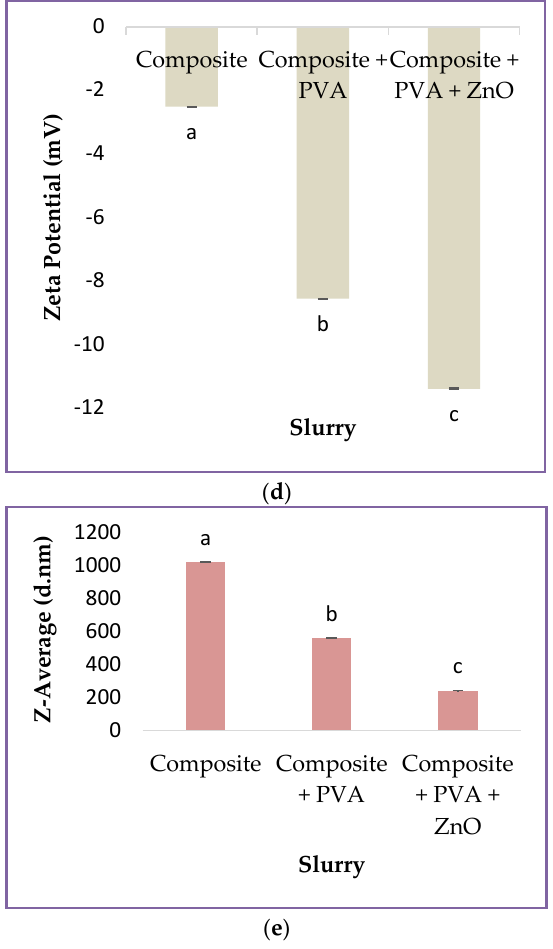
Figure 2. ( a – e ). Properties of different types of slurries used for film formation: ( a ) viscosity, ( b ) pH, ( c ) PDI, ( d ) zeta potential, and ( e ) Z-average. Means with different superscripts a – c differ significantly ( p < 0.05).